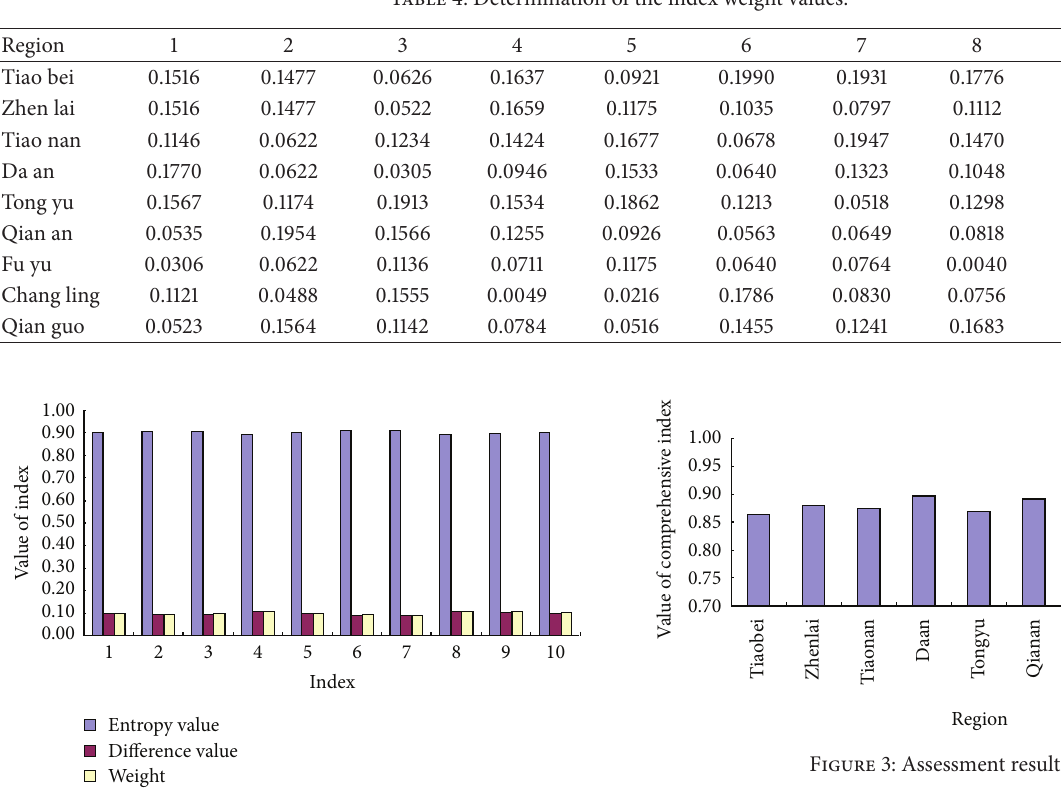
Figure 2: Determination of the index weight.